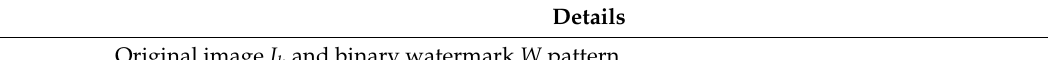
Table 1. Embedding procedure